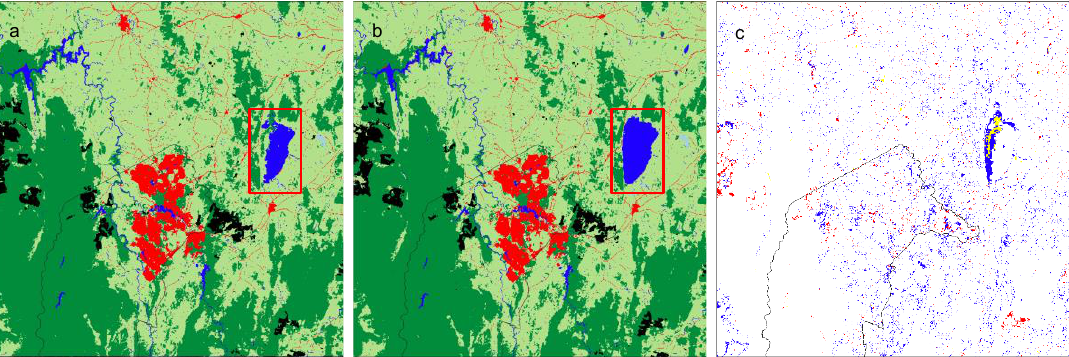
Figure 5. U-Net CNN model results for 2015 ( a ); and 2016 ( b ) (legend as for Figure 3); and change map ( c ). Highlighting differences: no change (white), possible (blue), unlikely (yellow), and implausible (red). Table 7. Transition matrix showing the number of pixels with no (bold), possible (plain text), unlikely (italics) and implausible (underlined) land cover change from 2015 to 2016. Note that the CNN method did not map any cropland.